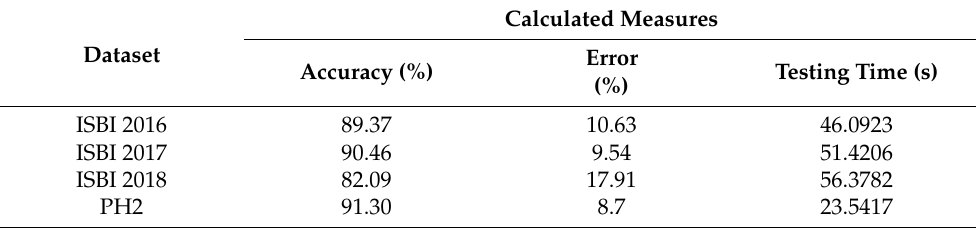
Table 3. Comparison of segmentation accuracy of the proposed method with existing methods.